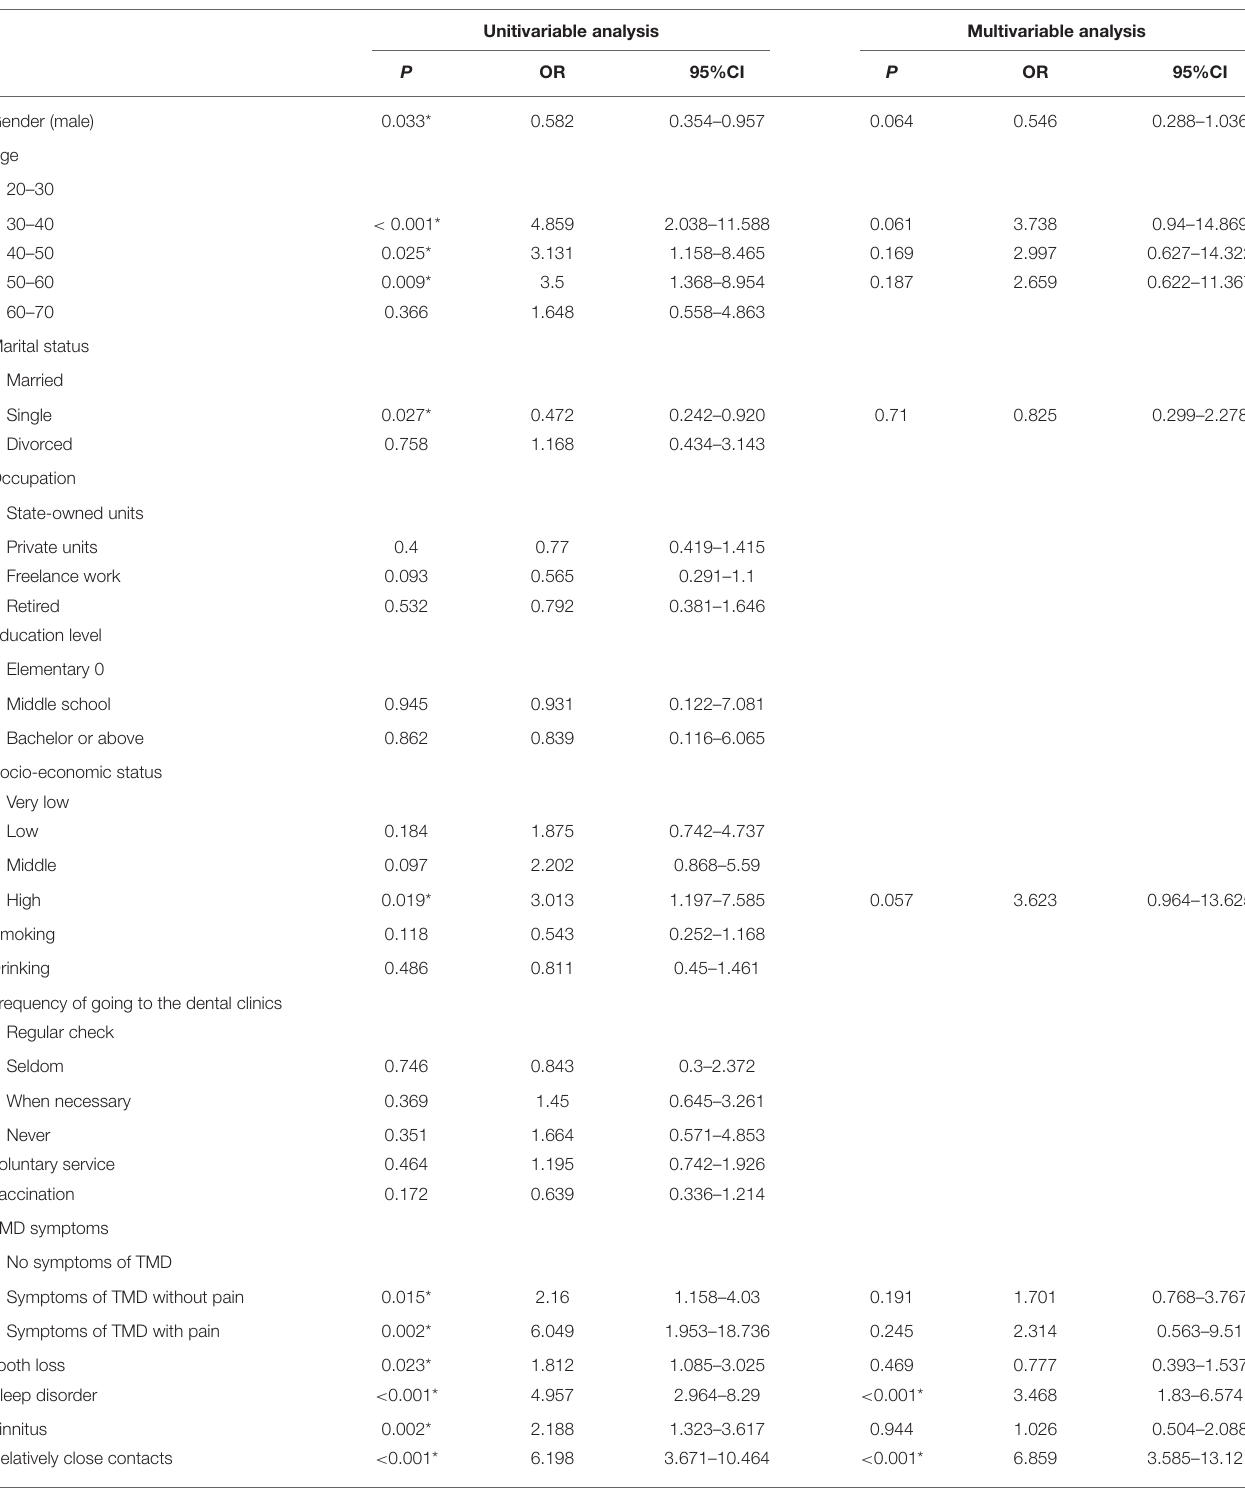
TABLE 6 | Factors of the occurrence of anxiety. Unitivariable analysis Multivariable